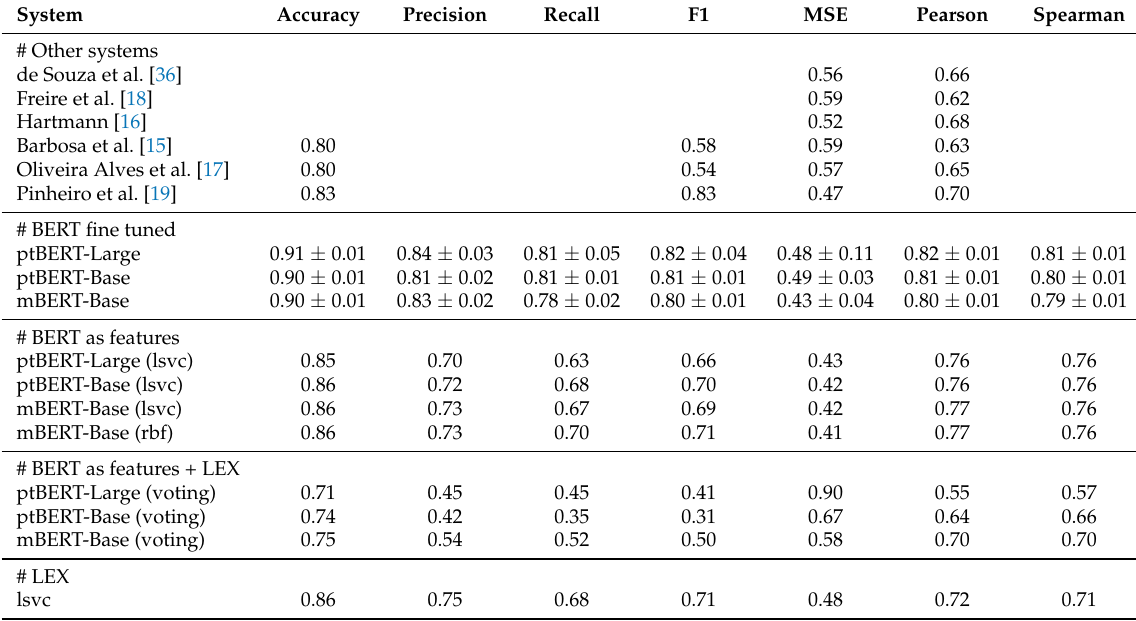
Table 5. ASSIN (PTPT + PTBR) NLI and STS results.